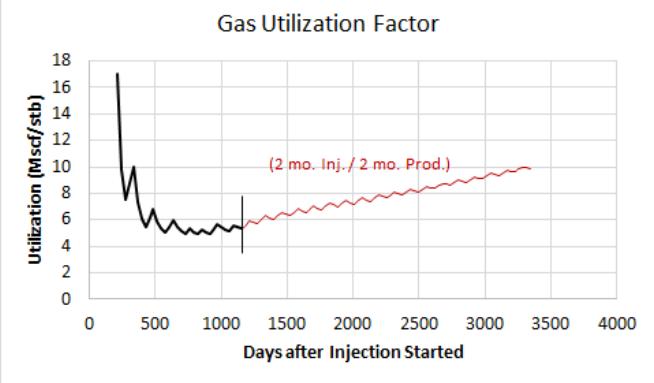
Figure 22. Gas utilization factor for huff-n-puff gas injection.